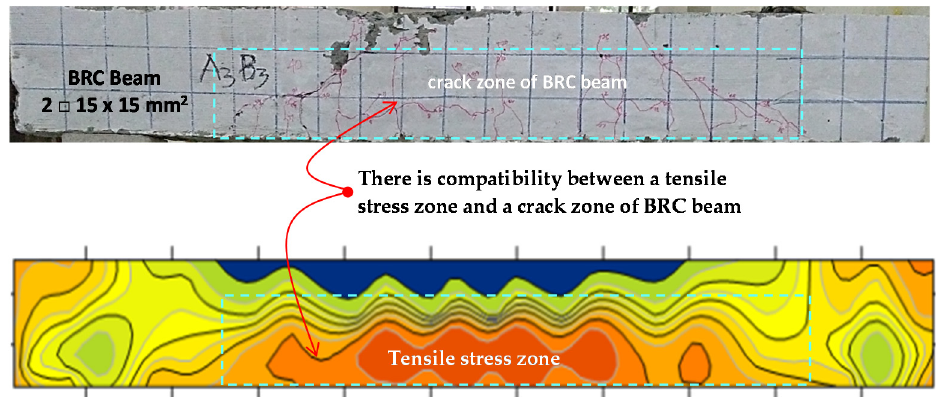
Figure 23. The crack pattern and tensile stress zone of BRC beam.